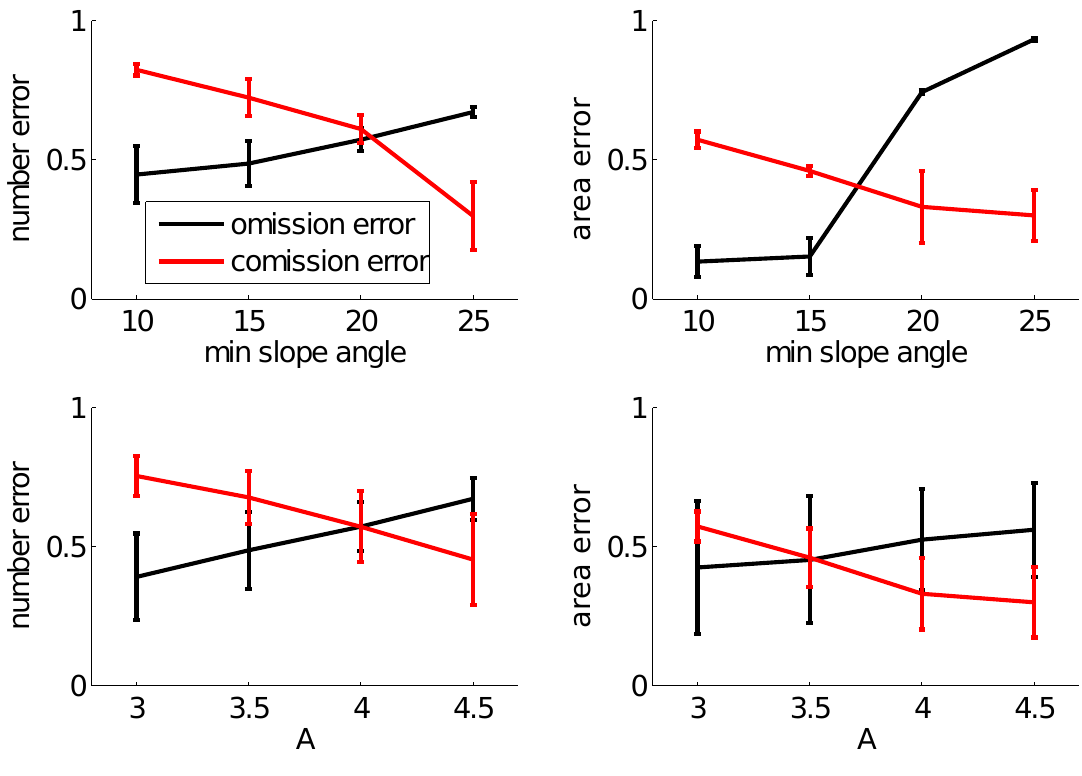
than the number errors. This indicates that the method is more suitable to detect large landslides than the smaller ones. All landslides larger than 700 m 2 (=28 pixels) are detected by the method. Figure 7. Effect of the minimum slope angle α (top) and the threshold parameter A (bottom) on the error of omission (black) and commission (red) for landslide number (left) and area (right). Error bars are calculated by the standard deviation of the omission and commission when parameters other than α or A vary in the range defined by the Table